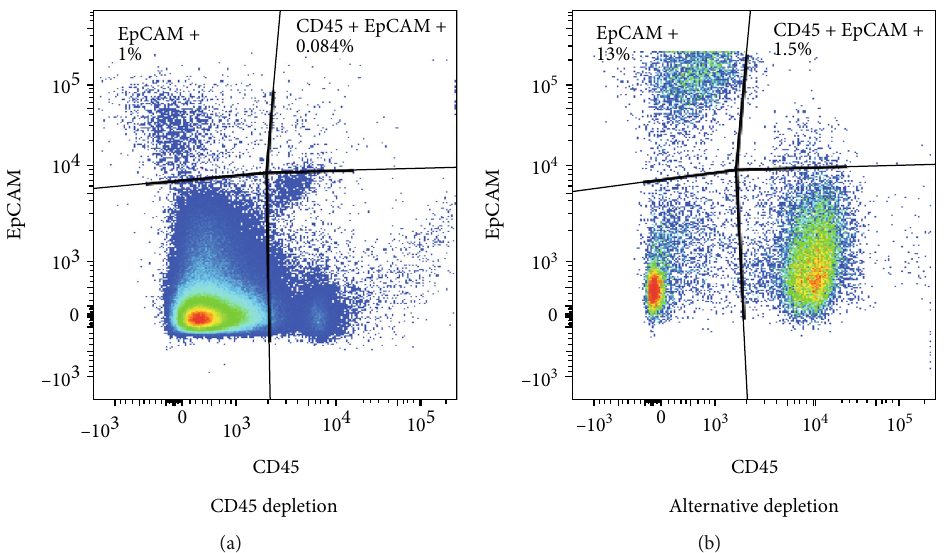
Figure 1: An alternative hematopoietic cell depletion method reveals a previously unidenti fi ed CD45+ EpCAM+ population in the thymus. FACS pro fi les show viable single cells gated on CD11c-, CD11b-, and CD19- cells. (a) Shows the presence of only 0.084% of CD45+ EpCAM + cells present in dissociated thymic tissue when using the sheep-anti-CD45 antibody followed by antisheep magnetic beads for the depletion of hematopoietic cells. (b) Shows enrichment of the CD45+ EpCAM+ population to 1.5% derived from dissociated thymic tissue when a cocktail of sheep anti-Thy1.2, anti-CD11b, anti-CD11c, and anti-CD19 antibodies followed by antisheep magnetic beads was used in place of anti-CD45. A minimum of three replicates of all experiments were